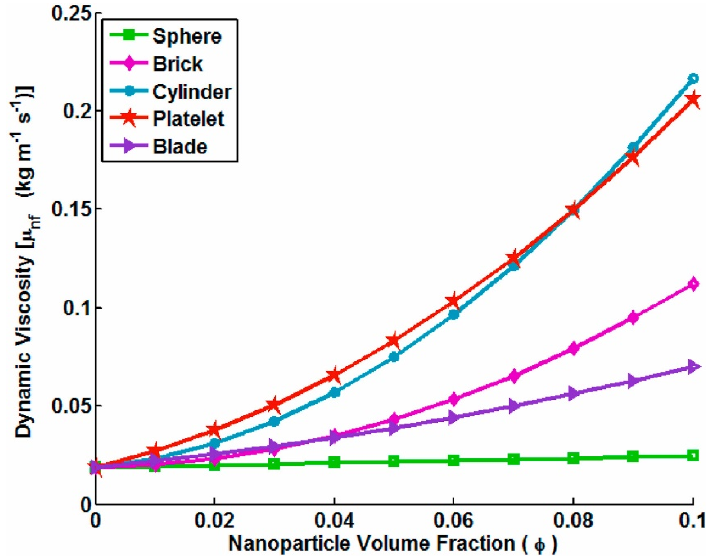
Figure 9. Shape effects on the dynamic viscosity of a nanofluid versus the nanoparticle volumetric concentration [61].